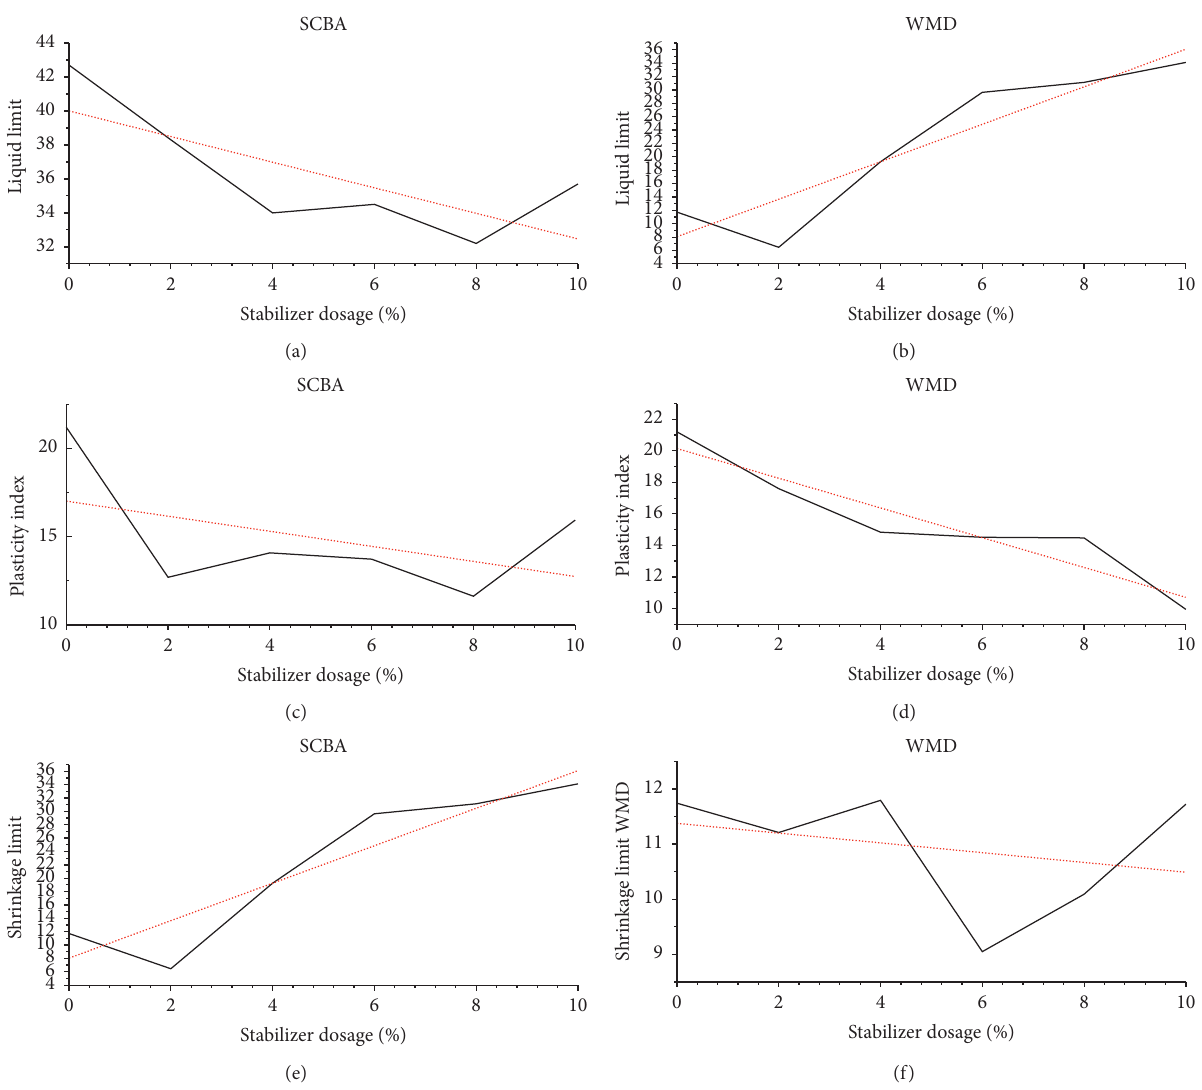
Figure 7: Variation of Atterberg limits by incorporating SCBA, (a) liquid limit, (c) plasticity index, (e) shrinkage limit, and by incorporating WMD, (b) liquid limit, (d) plasticity index, and (f) shrinkage